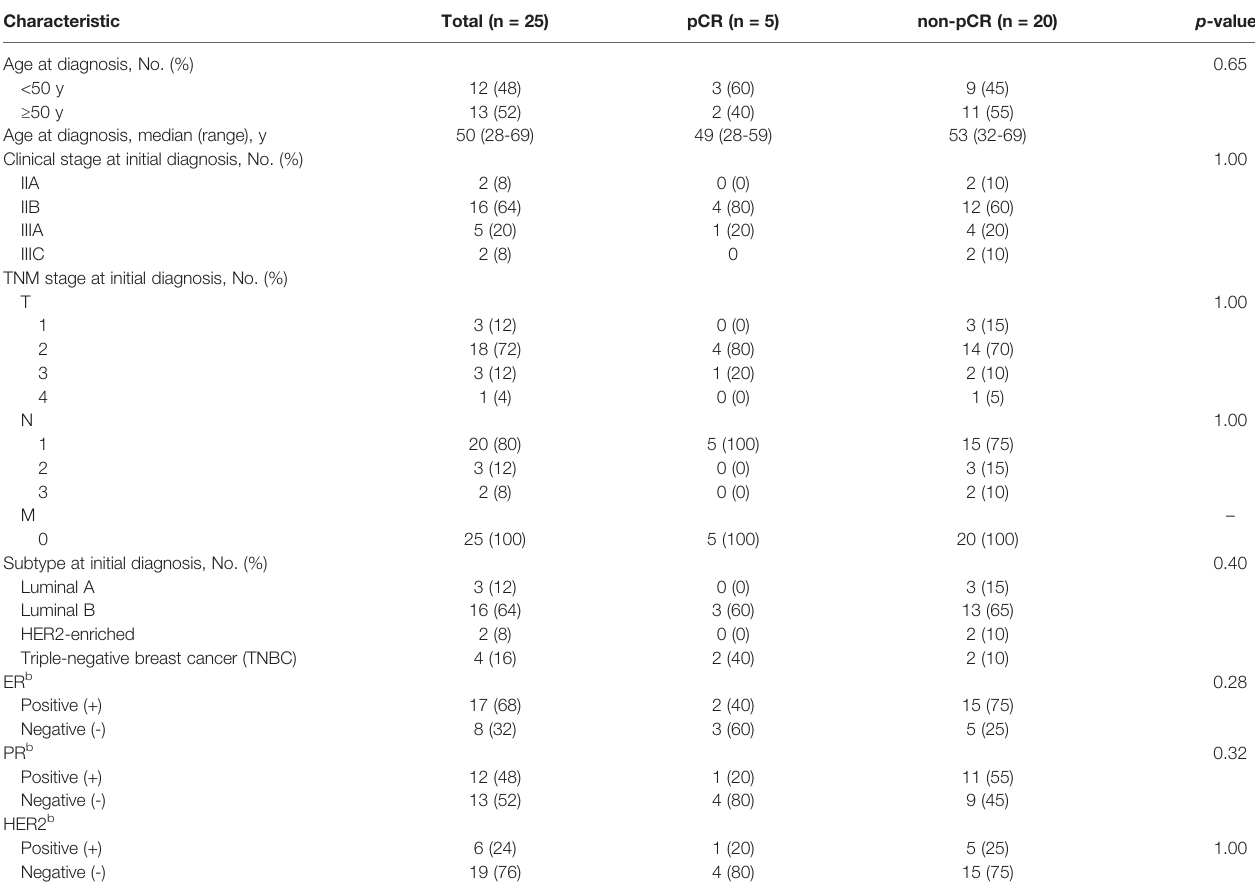
TABLE 1 | Overview of Patient Demographics and Clinical Characteristics.